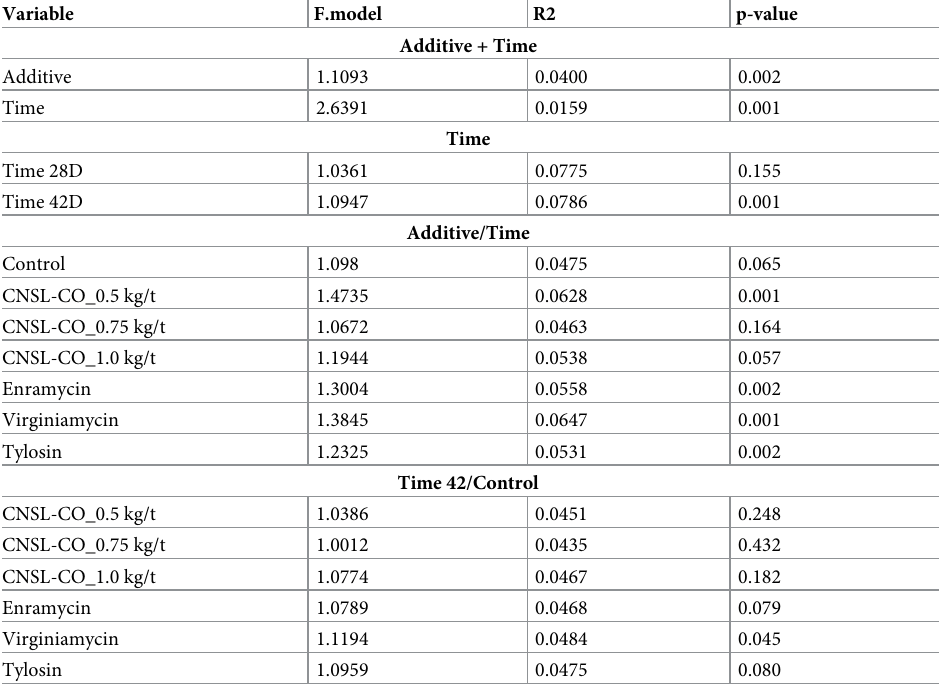
Table 2. Adonis test result of the beta diversity based on Bray–Curtis dissimilarity of broilers cecum samples at 28 and 42 d of trial with seven feed additives: Enramycin (8 ppm), virginiamycin (16.5 ppm), tylosin (55